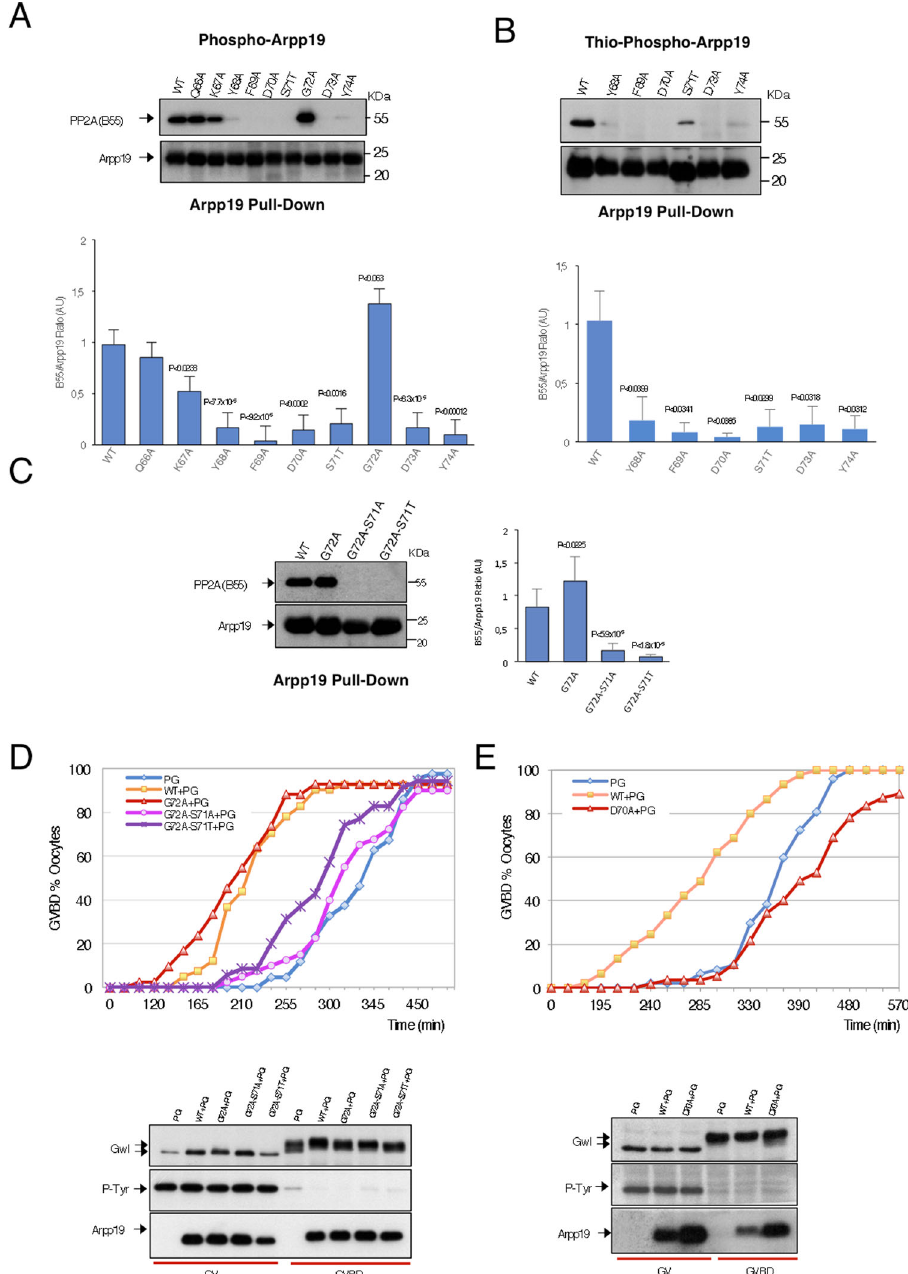
Fig. 3 S67/S71 catalysis and PP2A-B55 interaction regulate each other to confer a proper timing of PP2A-B55 inhibition. A B55 levels associated to 20 ng of wild type or the indicated DSG mutants of His-Arpp19-pulldowns. Arpp19 amount in these pulldowns is also shown. Data were represented as mean B55/Arpp19 ratio ± SD. Two-tailed unpaired Student ’ s t -tests were performed in each pulldown to determine statistical relevance. p vs. wild-type Arpp19 is shown; n = 3 biological independent samples for mutants Y68A, G72A and Y74A; n = 5 for the D73A, n = 6 for the wild-type form and n = 4 for the rest. B The wild type and the indicated DSG mutant forms of Arpp19 were thio-phosphorylated and used for His-pulldown. B55 and Arpp19 levels were checked by western blotting and shown. The B55/Arpp19 ratios were quanti fi ed and represented in a bar graph as mean ± SD. Two-tailed unpaired Student t -tests were performed in each pulldown to determine statistical relevance. p vs. wild-type Arpp19 is shown; n = 3 biological independent samples. C The B55/ Arpp19 ratios were obtained as in A for the indicated mutants and represented in a bar graph as mean ± SD. Two-tailed unpaired; p vs. wild-type Arpp19 is shown; n = 3 biological independent samples for the wild-type form; n = 8 for the G72A mutant, n = 5 for the G72A-S71A mutant and n = 3 for the G72A- S71T mutant. D Prophase oocytes were injected or not (PG) with 50 ng of the wild-type His-Arpp19 protein or with the indicated mutant forms and, 1 h later, treated with progesterone. GVBD was then scored as a function of time. Germinal vesicle (GV) and mature oocytes (GVBD) were western blotted to determine the levels of the injected protein, as well as the phosphorylation of Gwl and of the inhibitory site of Cdk1 Tyrosine 15. E As for E , except that the indicated mutant form of Arpp19 was